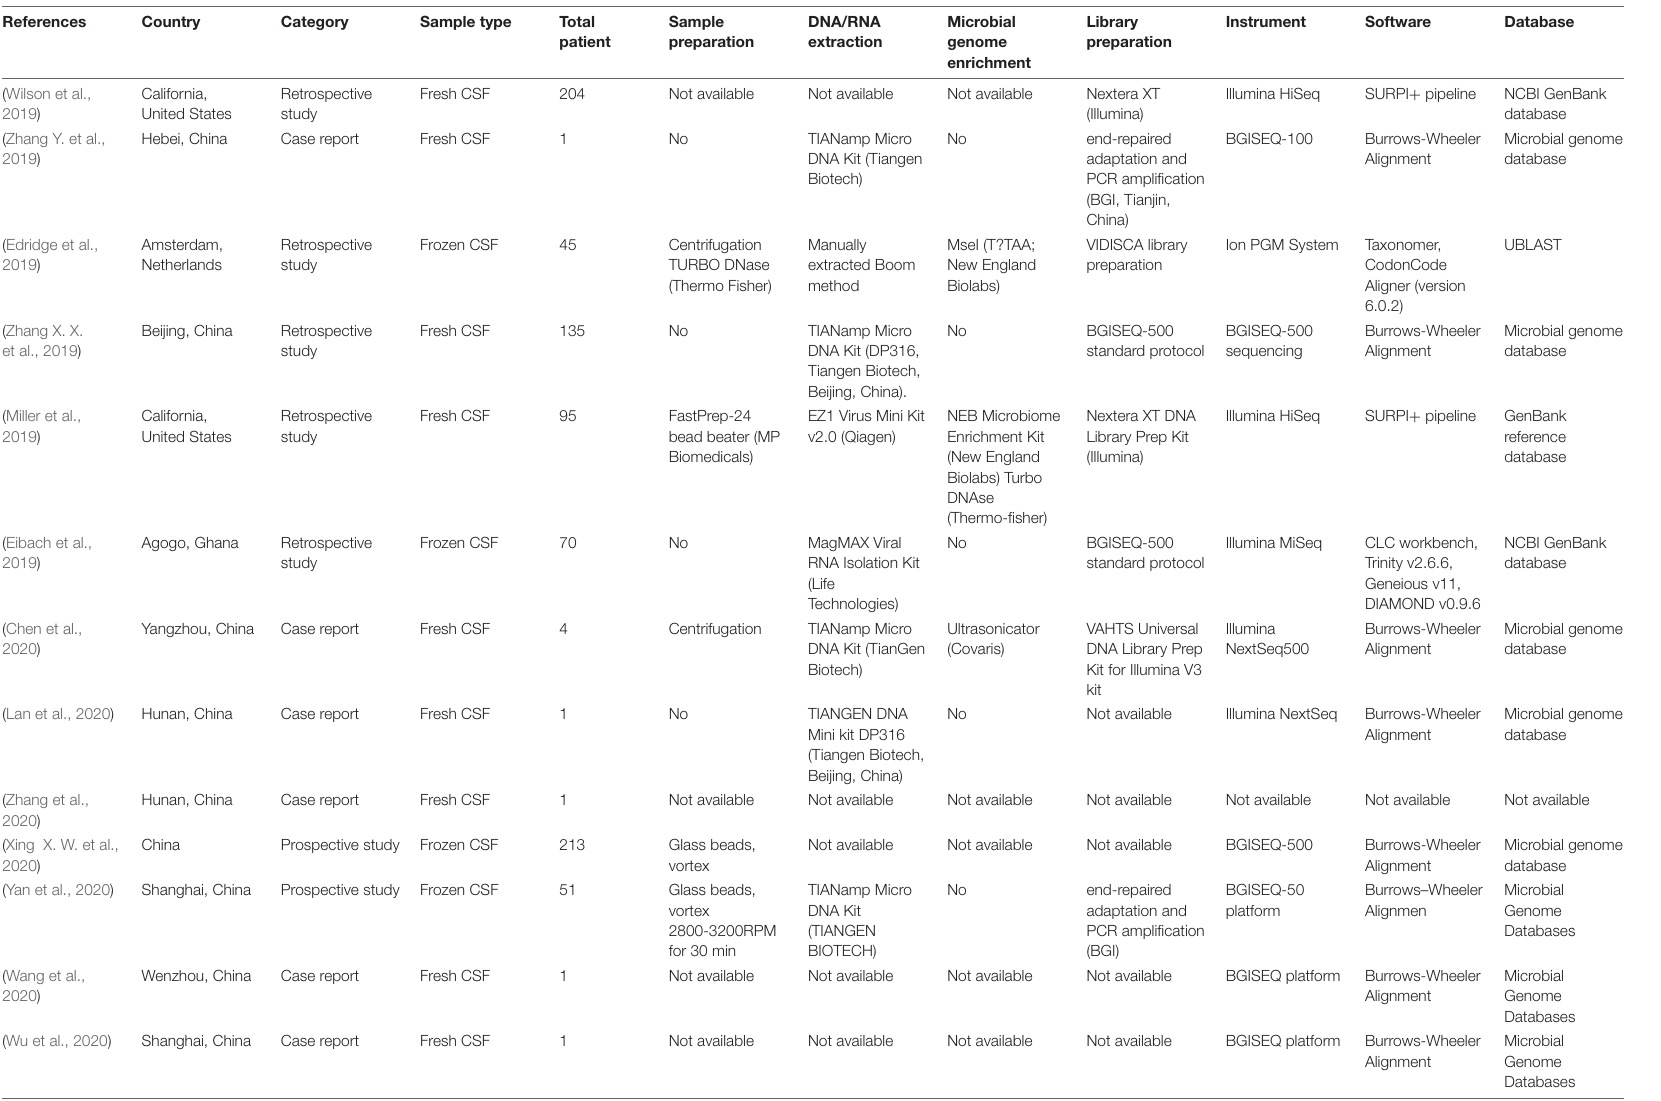
Not available Not available Not